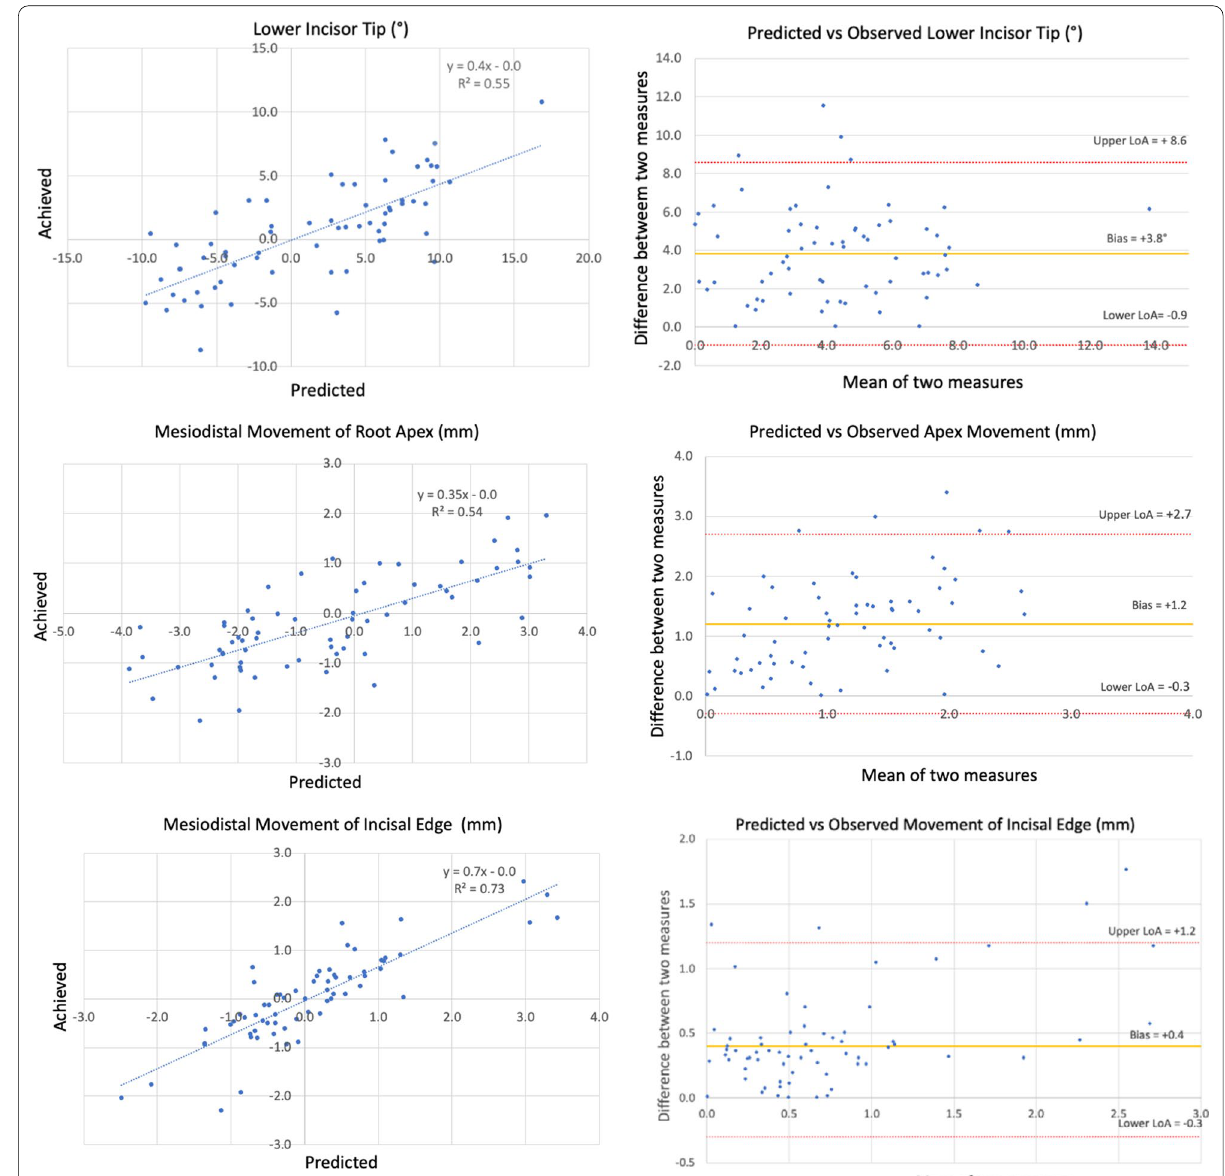
Fig. 2 Scatterplots of predicted values versus achieved values for lower incisor tip, mesio-distal movement of root apex and incisal edge movements. Scatterplot data (charts to the left) were fitted using linear regression analysis and the regression coefficients are given in the charts, including the coefficient of determinations ( R 2 ). The best linear fitting was obtained from the mesio-distal movement of incisal edge ( R 2 while the association between predicted and observed values was weaker for the lower incisor tip and the movement of root apex with R 2 values of 0.55 and 0.54, respectively. Bland–Altman plots were used to describe systematic differences between predicted and observed measurements. The difference between each pair of predicted and observed values was plotted against their mean value. This allowed estimate the mean bias between predicted and observed values and their upper and lower 95% limits of agreement